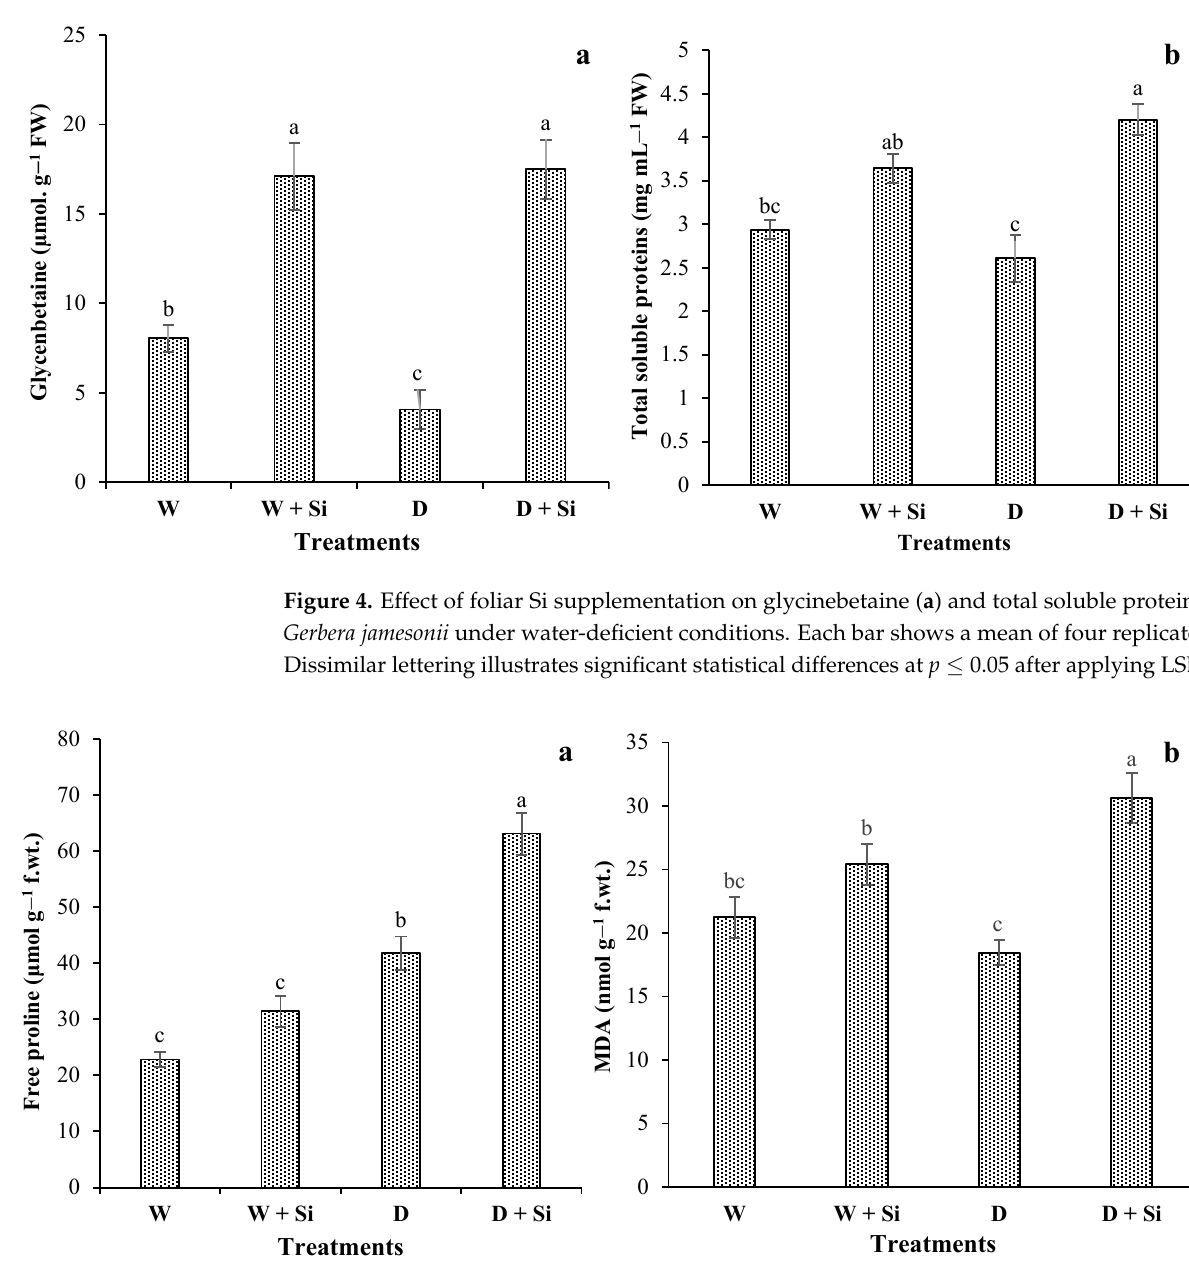
Figure 5. Impact of foliar Si supplementation on free proline ( a ) and MDA ( b ) of Gerbera jamesonii under water-deficient conditions. Each bar shows a mean of four replicates ± SE. Dissimilar lettering illustrates significant statistical differences at p ≤ 0.05 after applying LSD test.